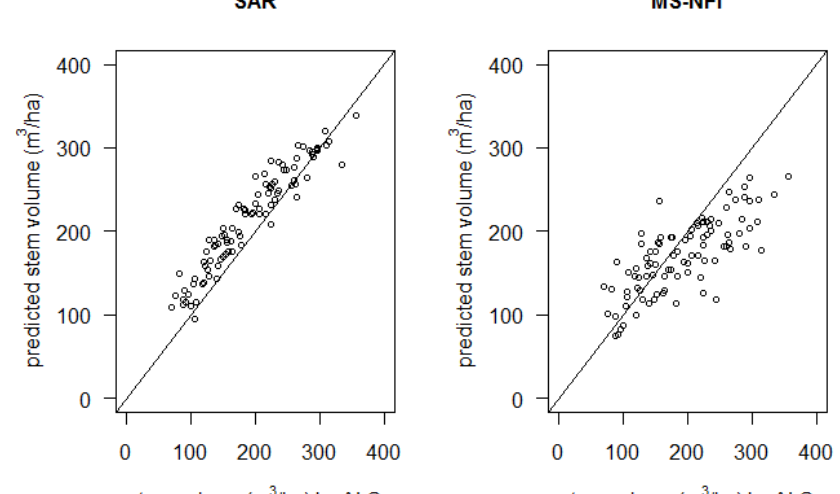
Figure 5. Stand-level stem volume estimates by stereo-SAR and multi-source NFI related to area-based ALS